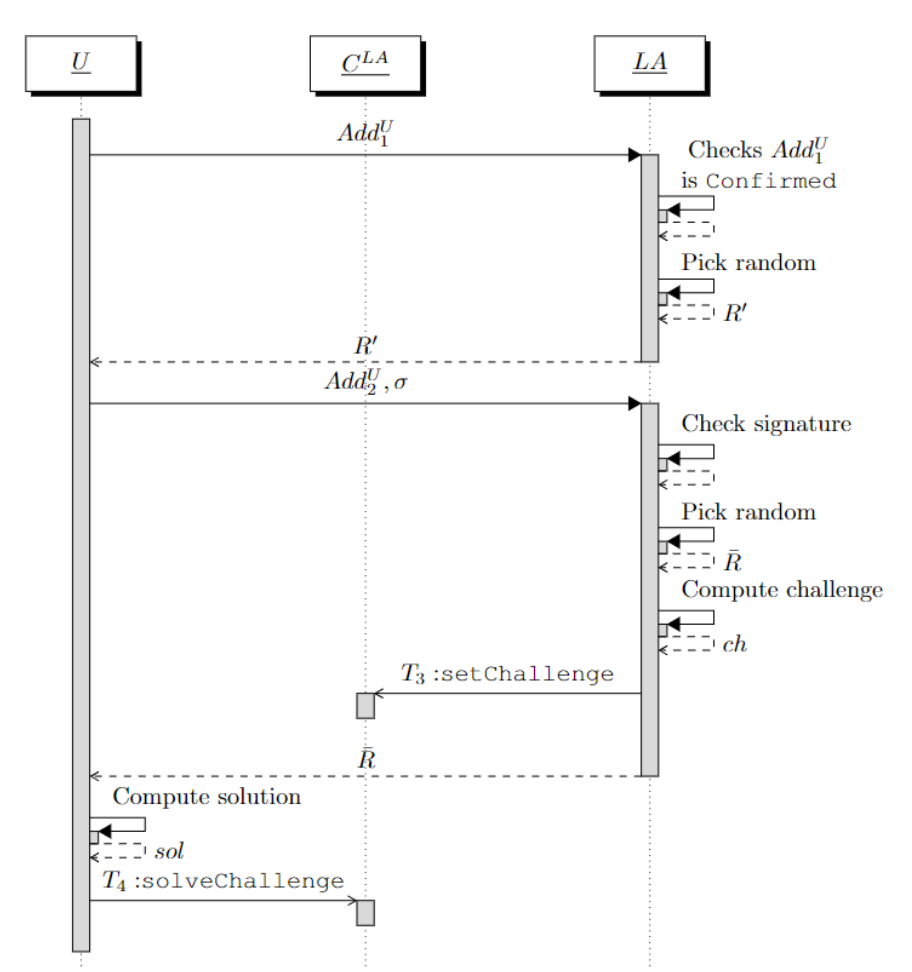
Figure 2. Sequence diagram of the interaction between U and LA